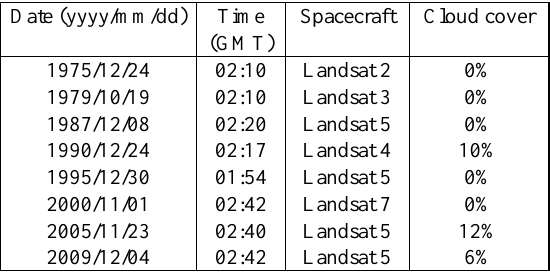
Table 1. Landsat images data between the 1975 and 2009 in Hong Kong